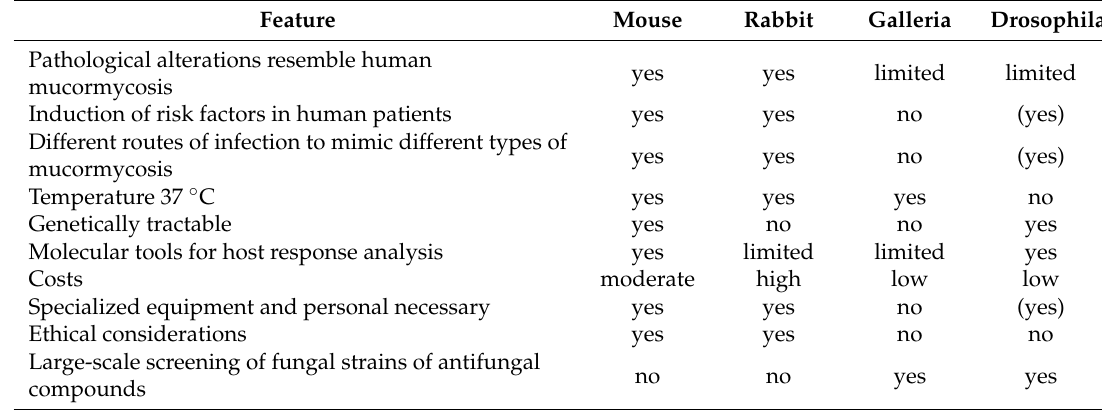
Table 4. The advantages and disadvantages of different animal models of